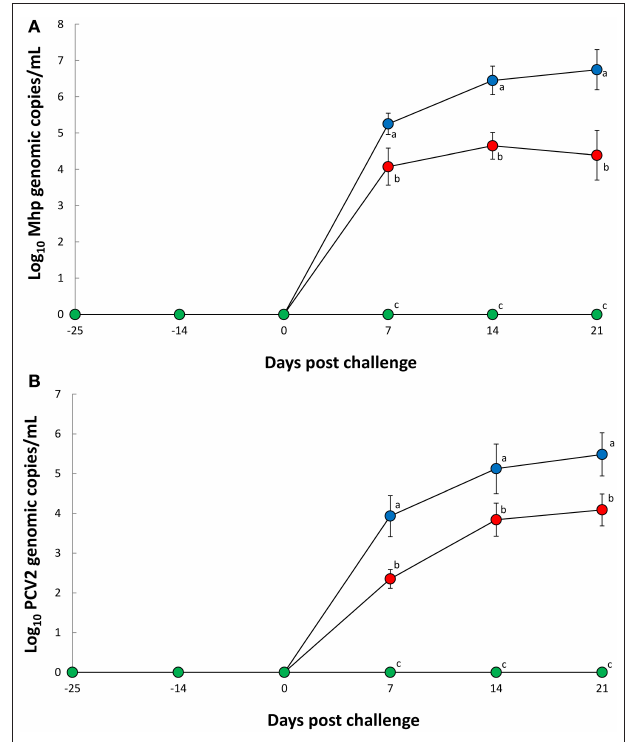
FIGURE 1 | Mean values of the genomic copy number of Mycoplasma hyopneumoniae DNA in nasal swabs (A) and porcine circovirus type 2b in blood (B) from Vac/Ch ( ), UnVac/Ch ( ), and UnVac/UnCh ( ) groups. Variation is expressed as the standard deviation. Different superscripts (a, b, and c) indicate significant ( P < 0.05) difference among three